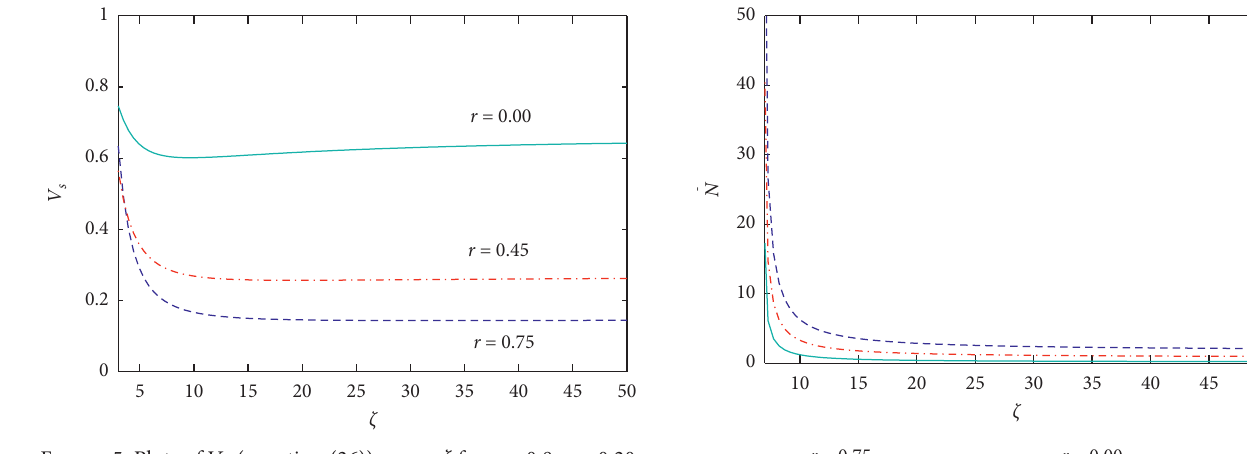
Figure 5: Plots of V � 0 . 8, ε � 0 . 20, s (equation (26)) versus ζ for κ and A � 2 . 5 and for different values of r . Figure 7: Plots of the steady state mean photon number (equation (57)) versus ζ for κ � 0 . 8, ε � 0 . 20, and A � 2 . 50 and for different values of r